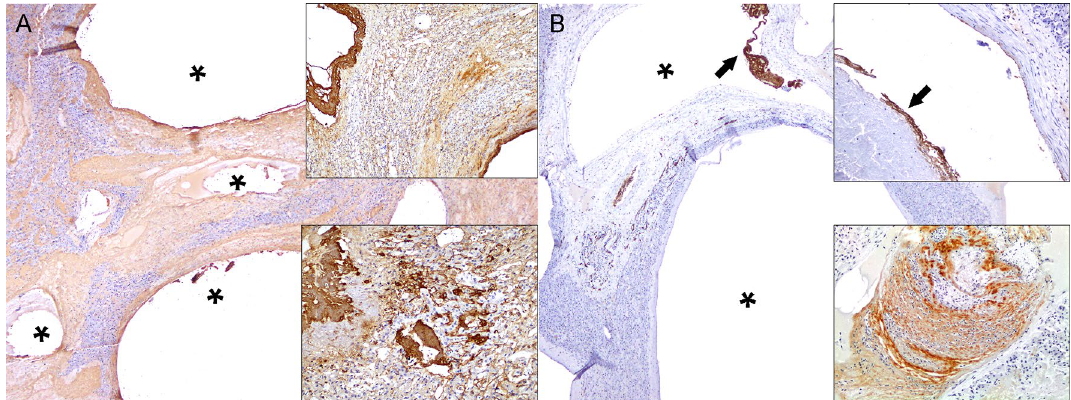
Figure 4. Immunohistochemical features of cystic liver lesions in dolphins. ( A ) Case 4. Fibrinogen. Fibrinogen labeled intravascular extracellular fibrillary material surrounding intravenous cystic spaces (asterisks) as well as non-organized and organized fibrin thrombi. Right upper and lower insets: detail of intravenous and sinusoidal fibrinogen labeling. ( B ) Case 4. Factor VIII is expressed in endothelial cells and some fibrin (arrow and right upper inset) clusters lining hepatic venous cystic dilatations (asterisks). Right lower inset: Partially organized fibrinous thrombus exhibits Factor VIII labeling.